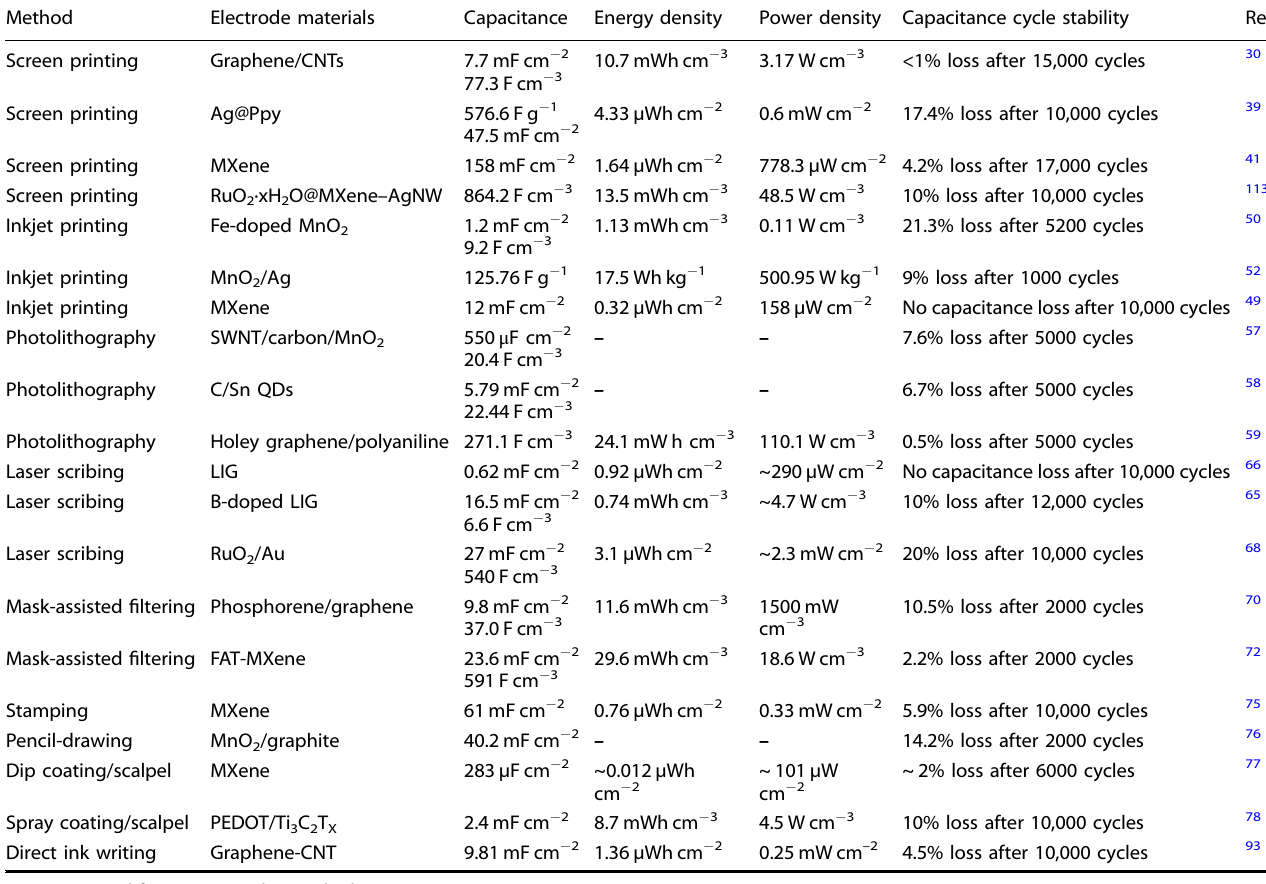
Table 1. Performance of MSCs with different methods and electrode